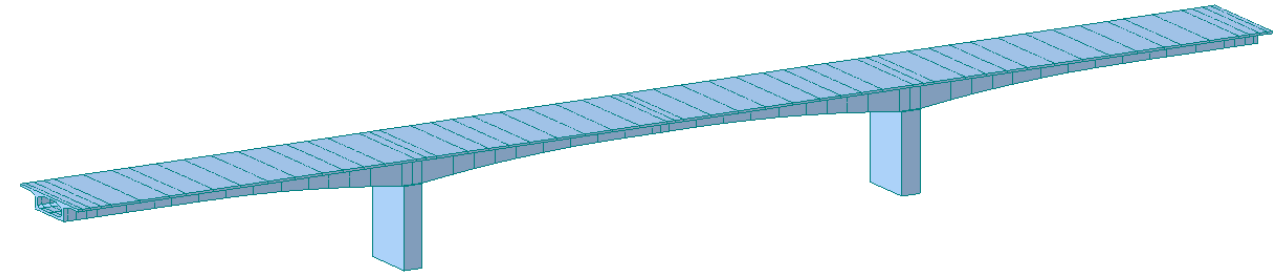
Figure 10. Numerical model of Huangsha Harbor Bridge after construction.